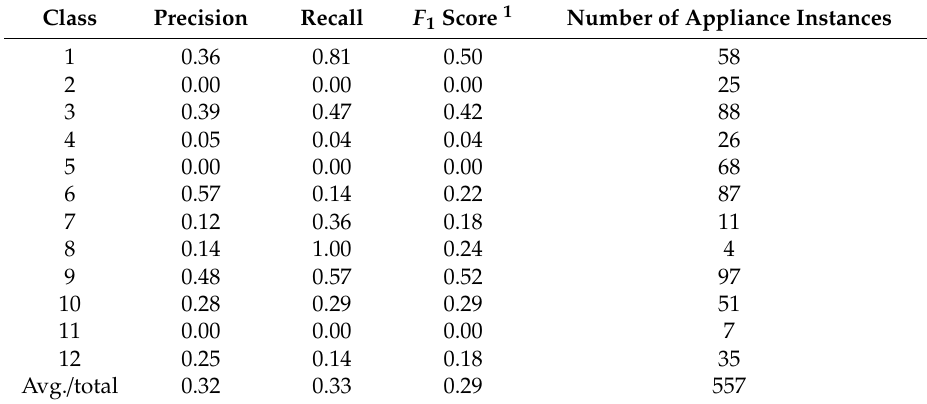
Table 3. Load recognition results obtained by the parallel computing accelerated GA.